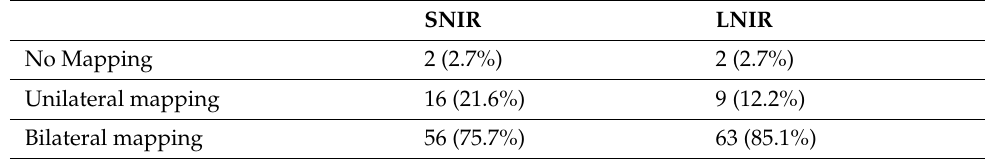
Table 2. Number of patients identified with lymph nodes with the two different probes.